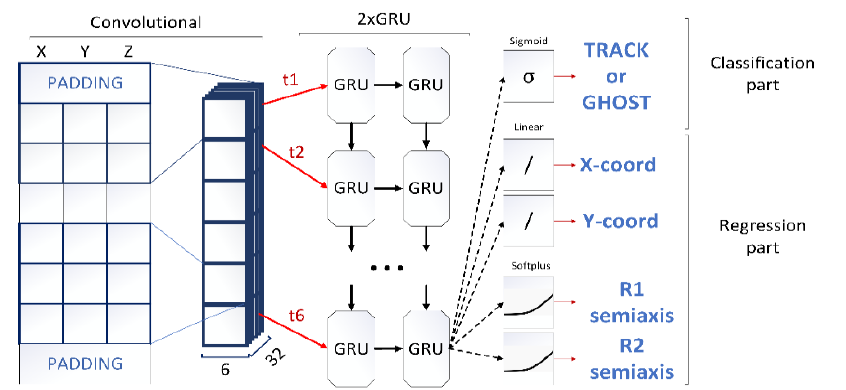
Fig. 1. The main scheme of the deep RNN for tracking. Worth to note that the size of output depends on input’s size, e.g. for sequences of size two the output contains only the regression part and for maximum size contains the only sigmoid